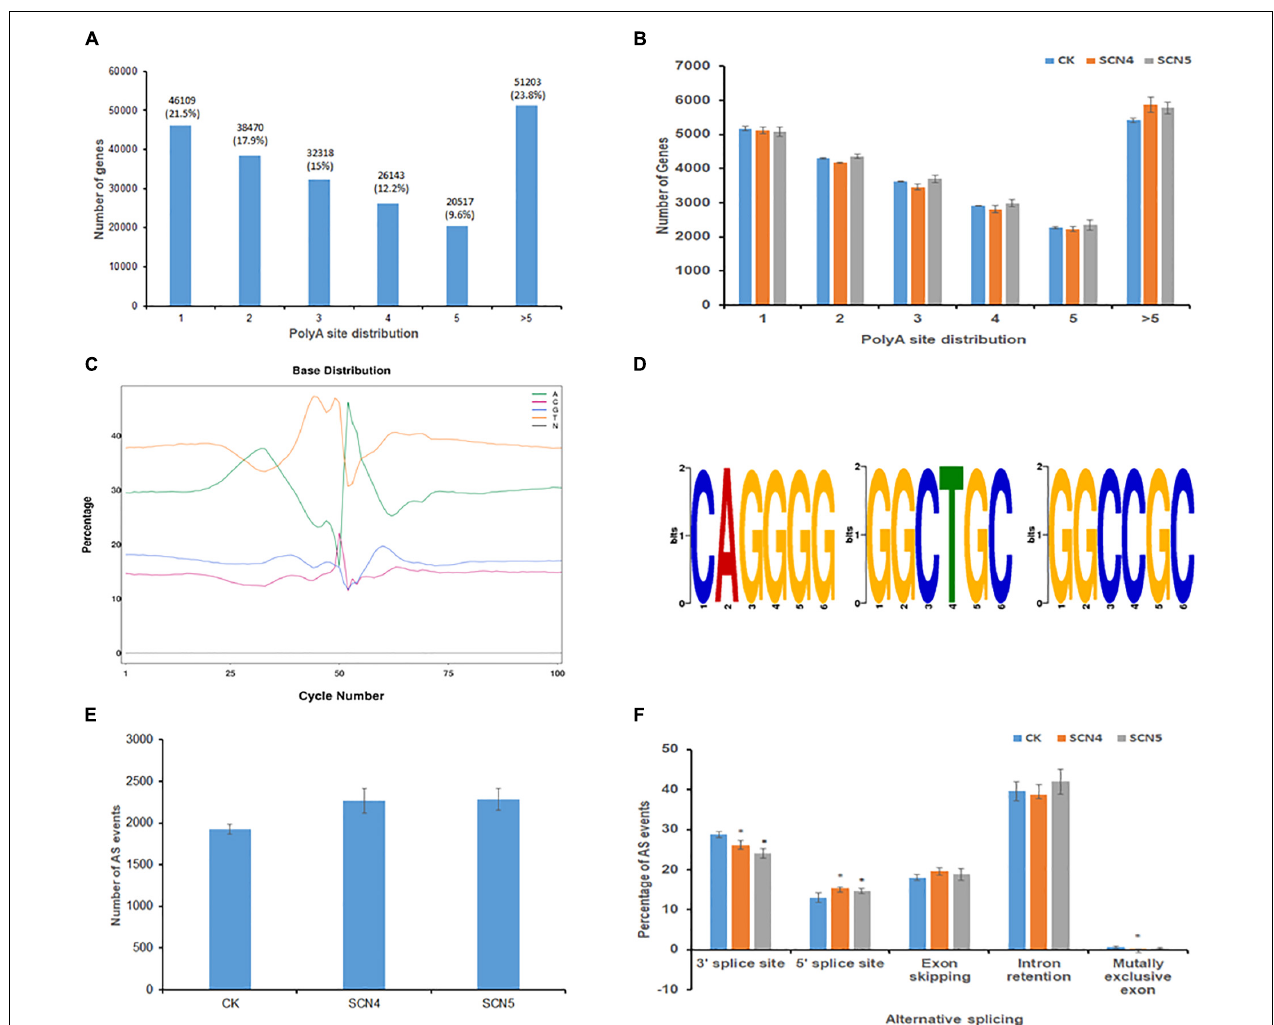
FIGURE 2 | Alternative polyadenylation (APA) and alternative splicing (AS) event analysis on soybean genotype 09-138 infected with soybean cyst nematode race 4 (SCN4) and race 5 (SCN5), and water as the control (CK). (A) Distribution of total poly A sites of genes. (B) Comparison of poly A site distribution among CK, SCN4, and SCN5 treatments. (C) Base distribution (in%) at 50 bp upstream and downstream of the poly A site of all transcripts. (D) Identified APA motifs. (E) Total AS number for CK, SCN4, and SCN5. (F) Comparison of AS events among CK, SCN4, and SCN5